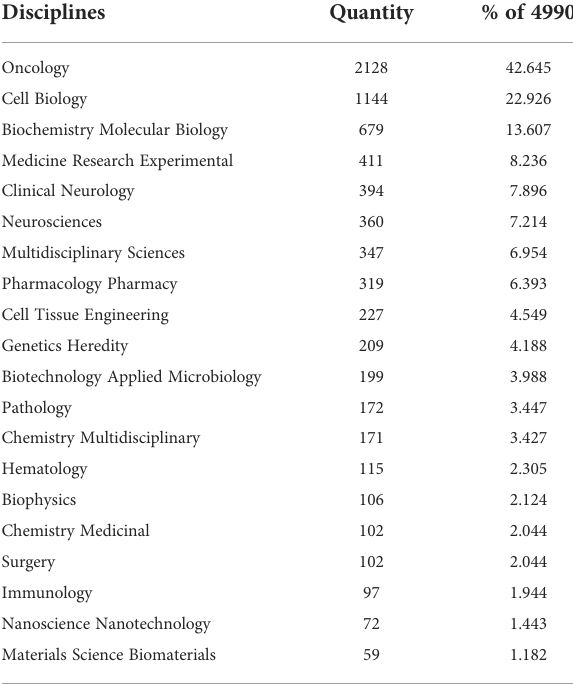
TABLE 3 The top 20 disciplines on glioma stem